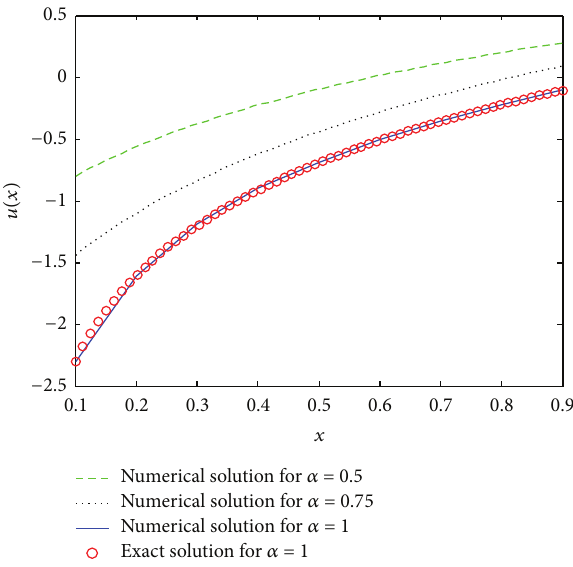
Figure 4: Numerical solution and exact solution of 𝛼 = 1